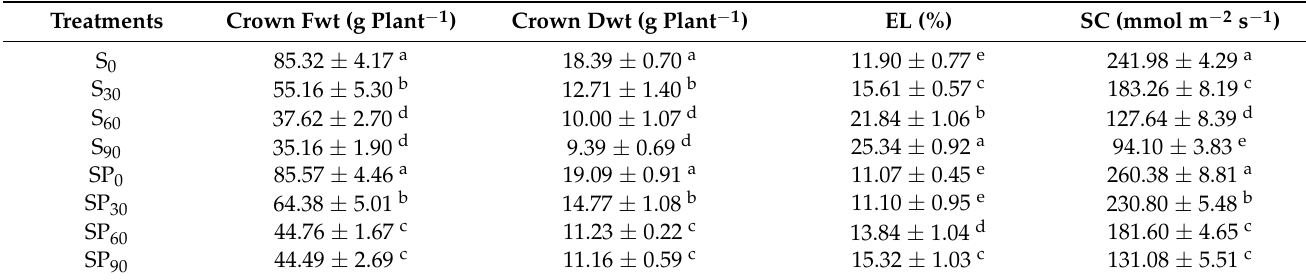
Table 1. Growth and physiological parameters of strawberry plants grown alone or in combination with P. oleracea at differing NaCl